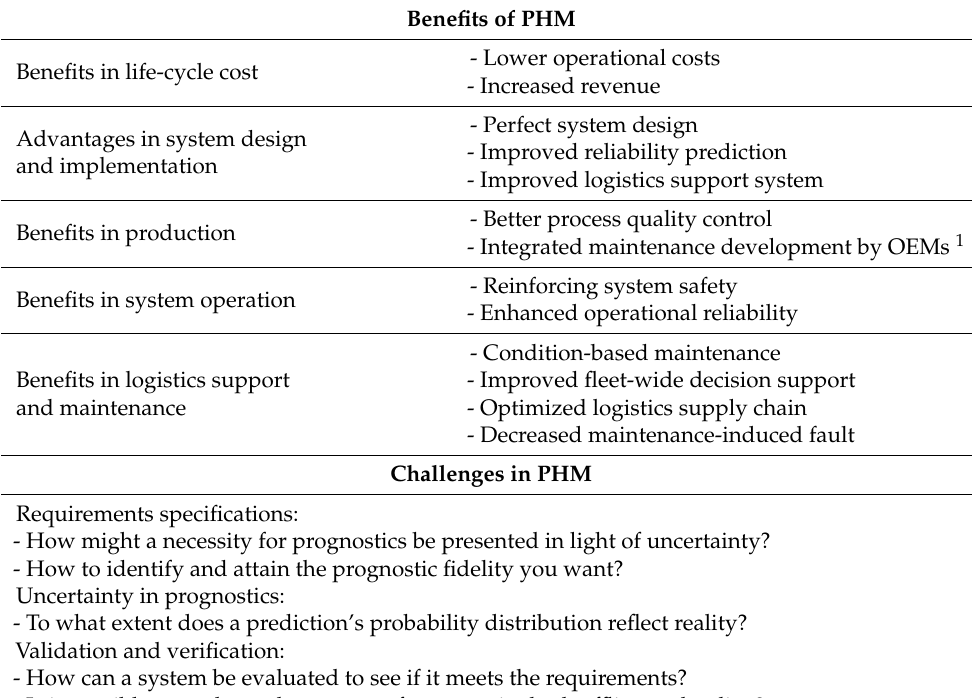
Table 2. Benefits and challenges for PHM. Reproduced from [15],